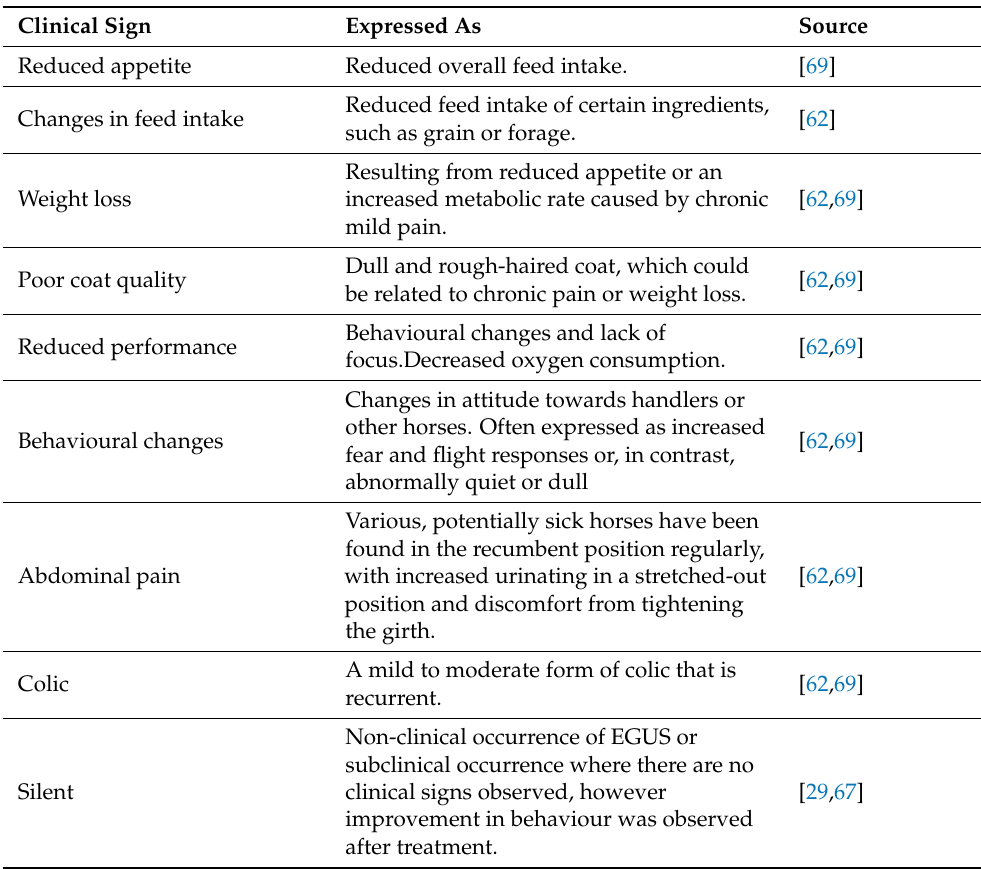
Table 2. Overview of clinical signs and manifestations of